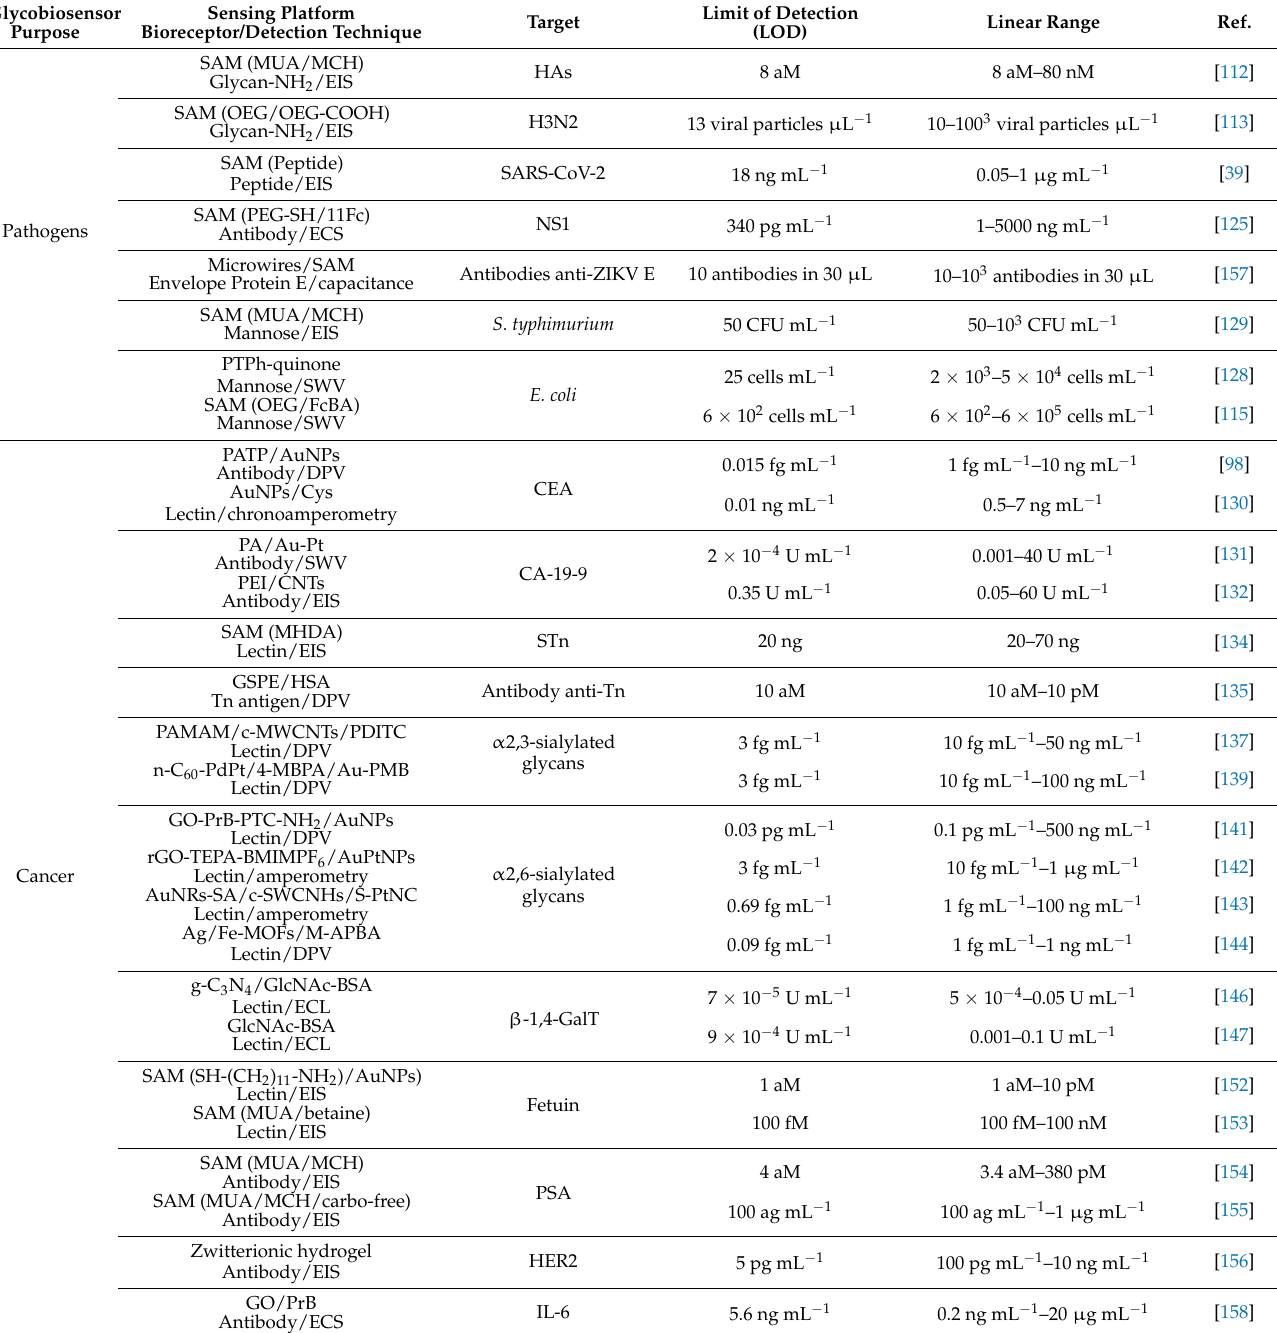
Table 3. Glycobiosensors for the detection of pathogens and cancer biomarkers reported in the last ten